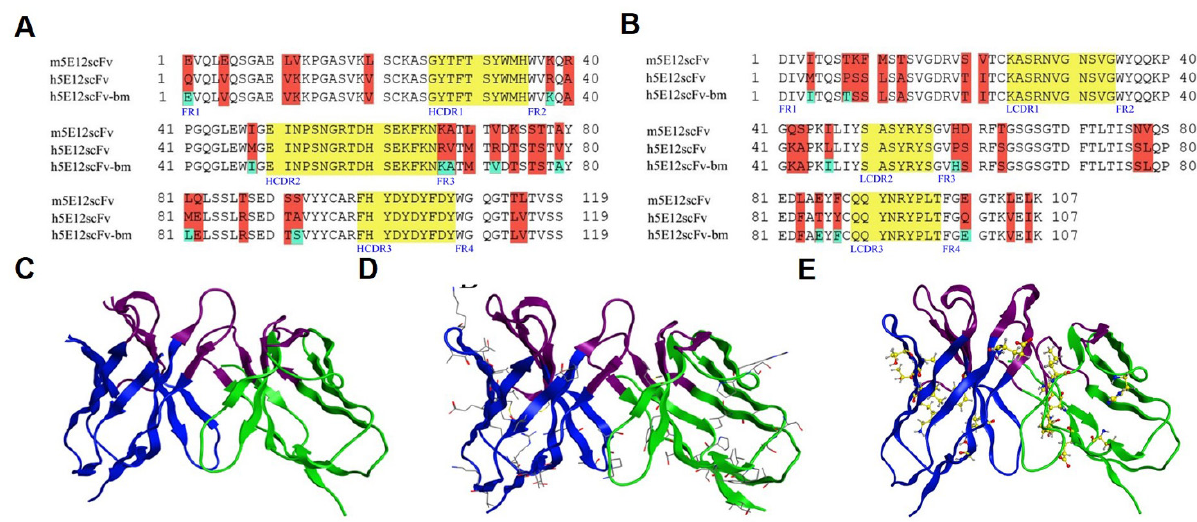
Figure 3. Humanization of m5E12scFv. ( A , B ) Sequence alignment of the VH ( A ) and VL ( B ) domain of m5E12scFv, h5E12scFv, and h5E12scFv-bm. The canonical residues back-mutated to murine residues in FRs of h5E12scFv-bm are marked in green, and the residues different between murine and humanized scFvs are marked in red. The CDRs are marked in yellow. ( C ) The homology modelled structures of m5E12scFv. The murine heavy chain (PDB ID: 10AR_H) and murine light chain (PDB ID: 1H8N_A) were used as templates for modelling of m5E12scFv. ( D ) The homology modelled structures of h5E12scFv. the homo heavy chain (PDB ID: 3HC0_H) and homo light chain (PDB ID: 1T04_A) were used as templates for modelling h5E12scFv. ( E ) The homology modelled structures of h5E12scFv-bm. The humanized heavy chain (PDB ID: 1IT9_H) and homo light chain (PDB ID: 1AD9_L) were used as templates for modelling h5E12scFv-bm. The FRs of heavy chains and light chains are presented in blue and green, respectively; the CDRs of variable regions are presented in purple; the residues in h5E12scFv different from m5E12scFv are presented in the skeletal formula; the back-mutated residues in h5E12scFv-bm are presented in the ball-and-stick formula.